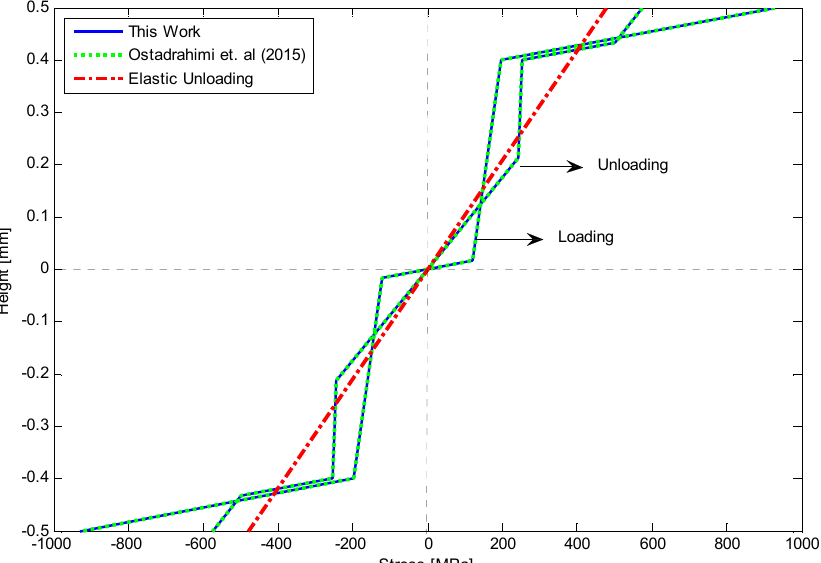
Figure 13. Comparison of stress–height relationship upon loading and unloading with elastic unloading for pure bending problem with symmetric tension–compression response [28].